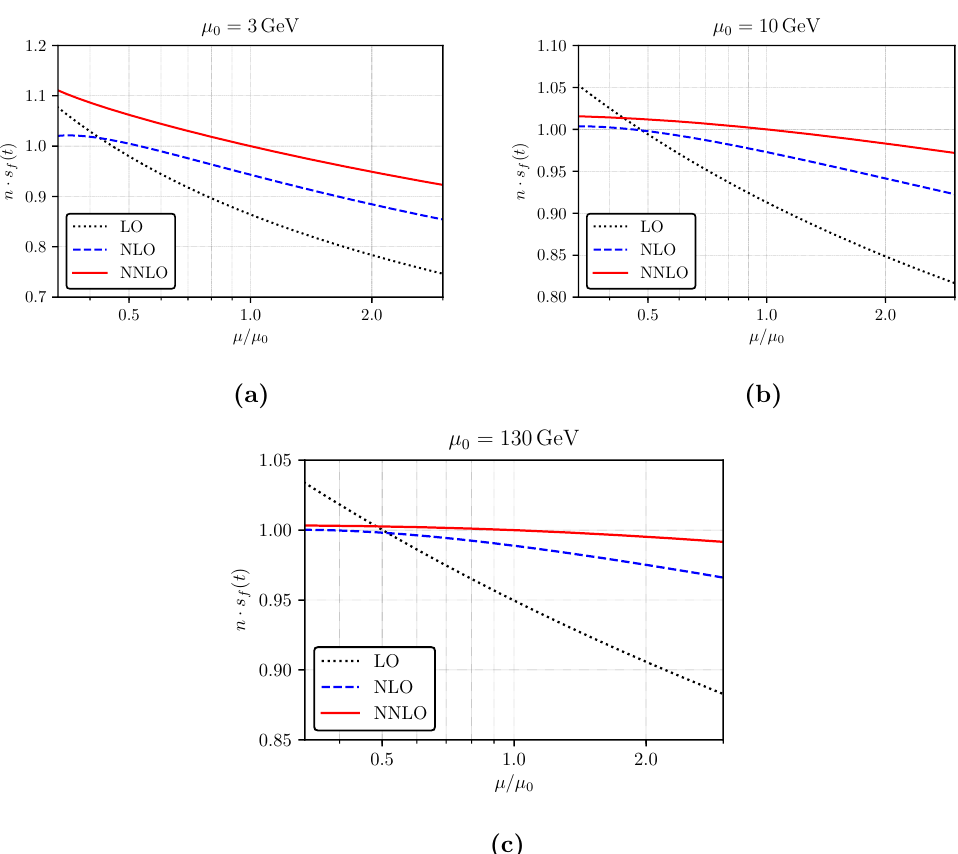
Figure 3 . Renormalization scale dependence of s f ( t ), de(cid:12)ned in eq. (4.21), for three di(cid:11)erent values of the central scale (cid:22) 0 = e (cid:0) (cid:13) E = 2 = p 2 t . (a) (cid:22) 0 = 3 GeV, corresponding to t = (0 : 03 fm) 2 , where we use n F = 3 and (cid:11) (3) s (3 GeV) = 0 : 248; (b) (cid:22) 0 = 10 GeV ( t = (0 : 01 fm) 2 ), where n F = 5 and (cid:11) (5) s (10 GeV)=0 : 178; (c) (cid:22) 0 =130 GeV ( t =(8 10 (cid:0) 4 fm) 2 ), where n F =5 and (cid:11) (5) s (130 GeV)=0 : 112. (cid:1) The running of (cid:11) s ( (cid:22) ) and m f ( (cid:22) ) is evaluated with the help of RunDec [56, 57] at the corresponding loop order. All curves are normalized to the NNLO result at (cid:22) = (cid:22) 0